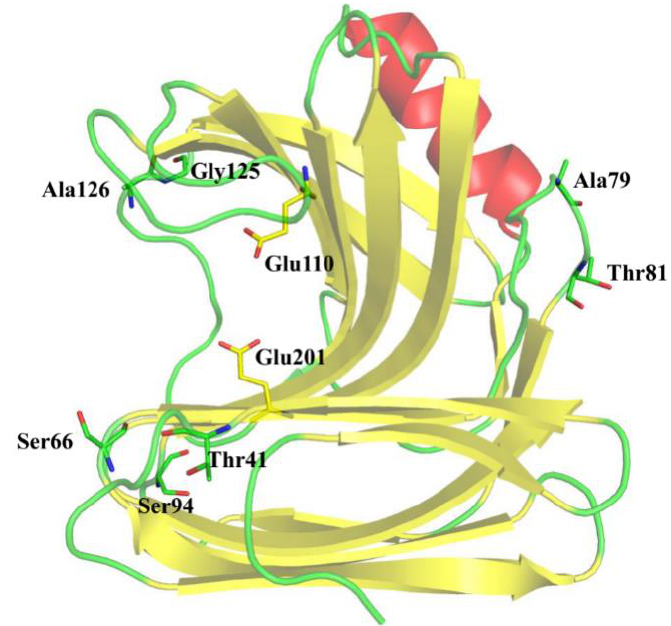
Figure 1. The model of wild-type XynASP. The whole structure of XynASP was visualized by the PyMOL using a cartoon model. The residues predicted by the FireProt and located in the loop region were indicated in color green, and the catalytic residues were indicated in color yellow.